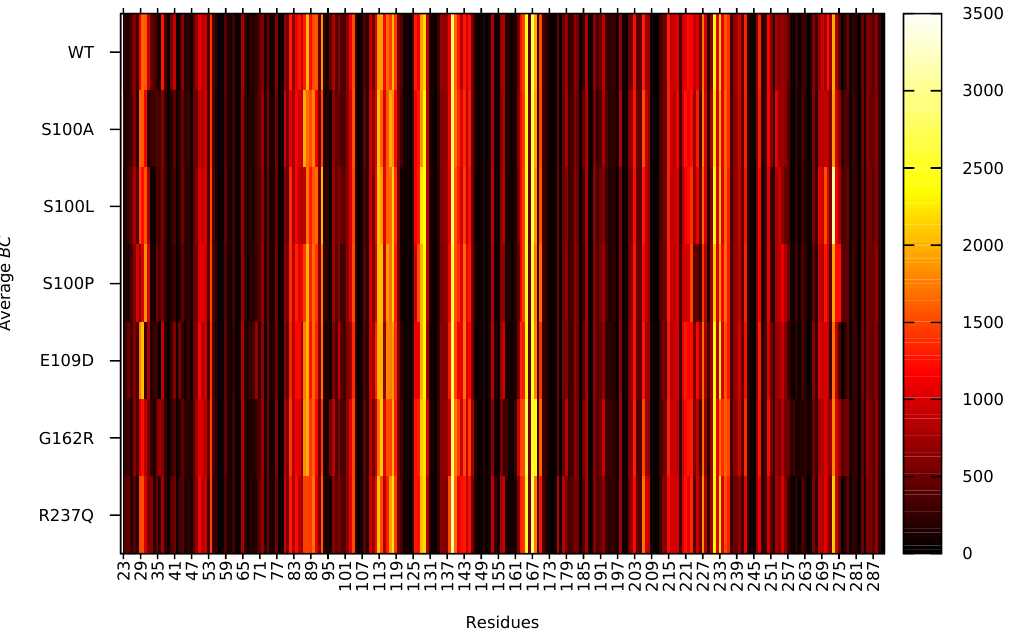
Figure 5. Non normalised average BC of the WT and variant protein residues during MD